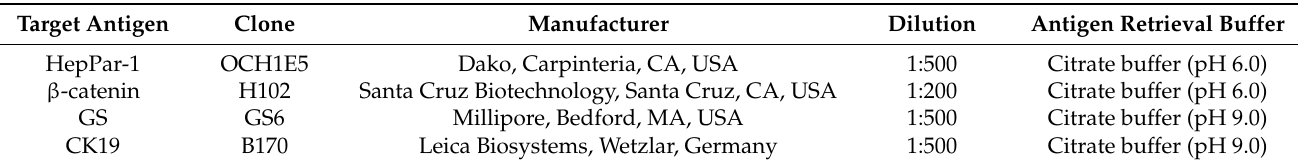
Table 1. Details of primary antibodies applied for the immunohistochemical evaluation of three- toed sloth hepatocellular carcinoma.